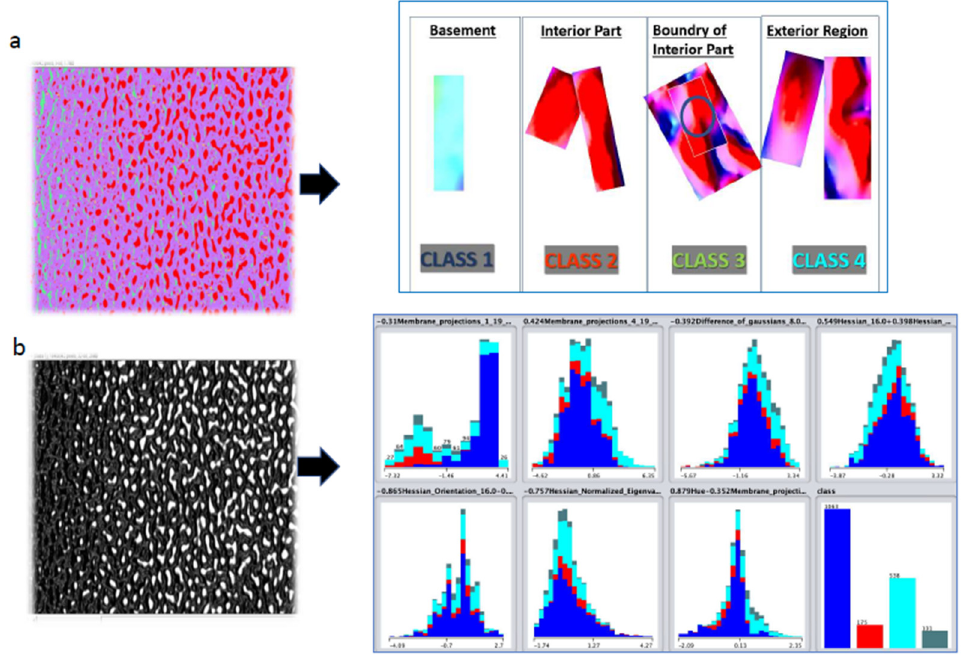
Figure 6. ( a ) 3D surface morphologies taken from the Cryo-TEM images. The information was used to develop a classification system; ( b ) visualization of exosomes according to their morphological features. The information was used for training the unsupervised learning.